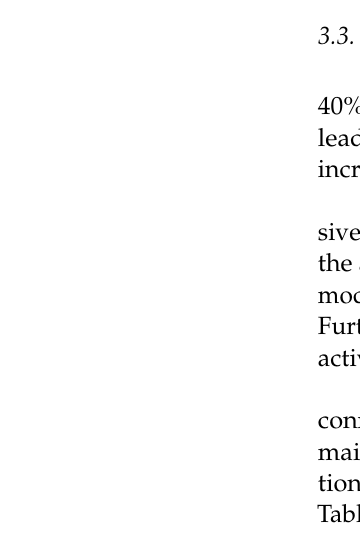
Table 3. Summary of potential benefits in depression after using rTMS in stroke patients in RCTs, reviews, and pilot studies (PSs) with a valid measure of the methodological quality of clinical trials using